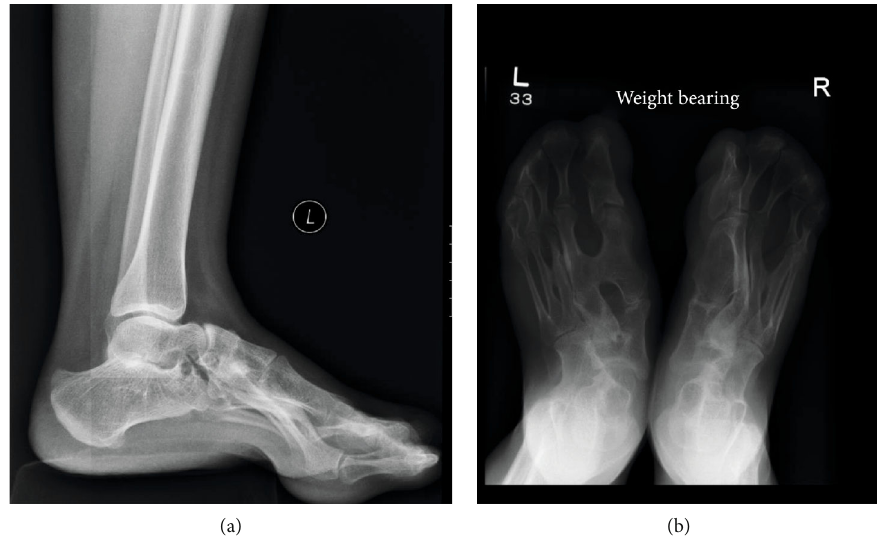
Figure 3: Companion case. 30-year-old man with the Apert syndrome. Lateral (a) and frontal (b) foot X-ray with multiple osseous synostosis involving both feet, including intermetatarsal coalition. Table 1: Available literature on intermetatarsal coalition on literature search via PubMed. Keyword coalition or synchondrosis or synostosis AND intermetatarsal or